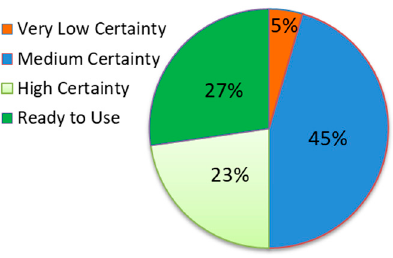
Figure 8. Distribution of 22 proxy indicators used in this study in terms of the level of certainty assessed by the authors’ expert judgement (from Table 1).